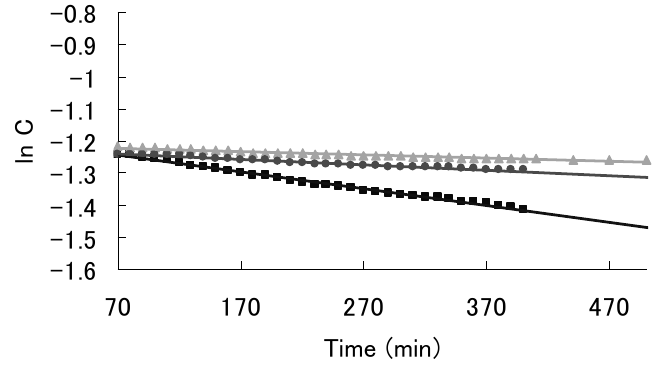
Figure 5. Time profile of the concentration of the zwitterions 10 ( ■ ), 12a ( ● ), and 12b ( ▲ ).